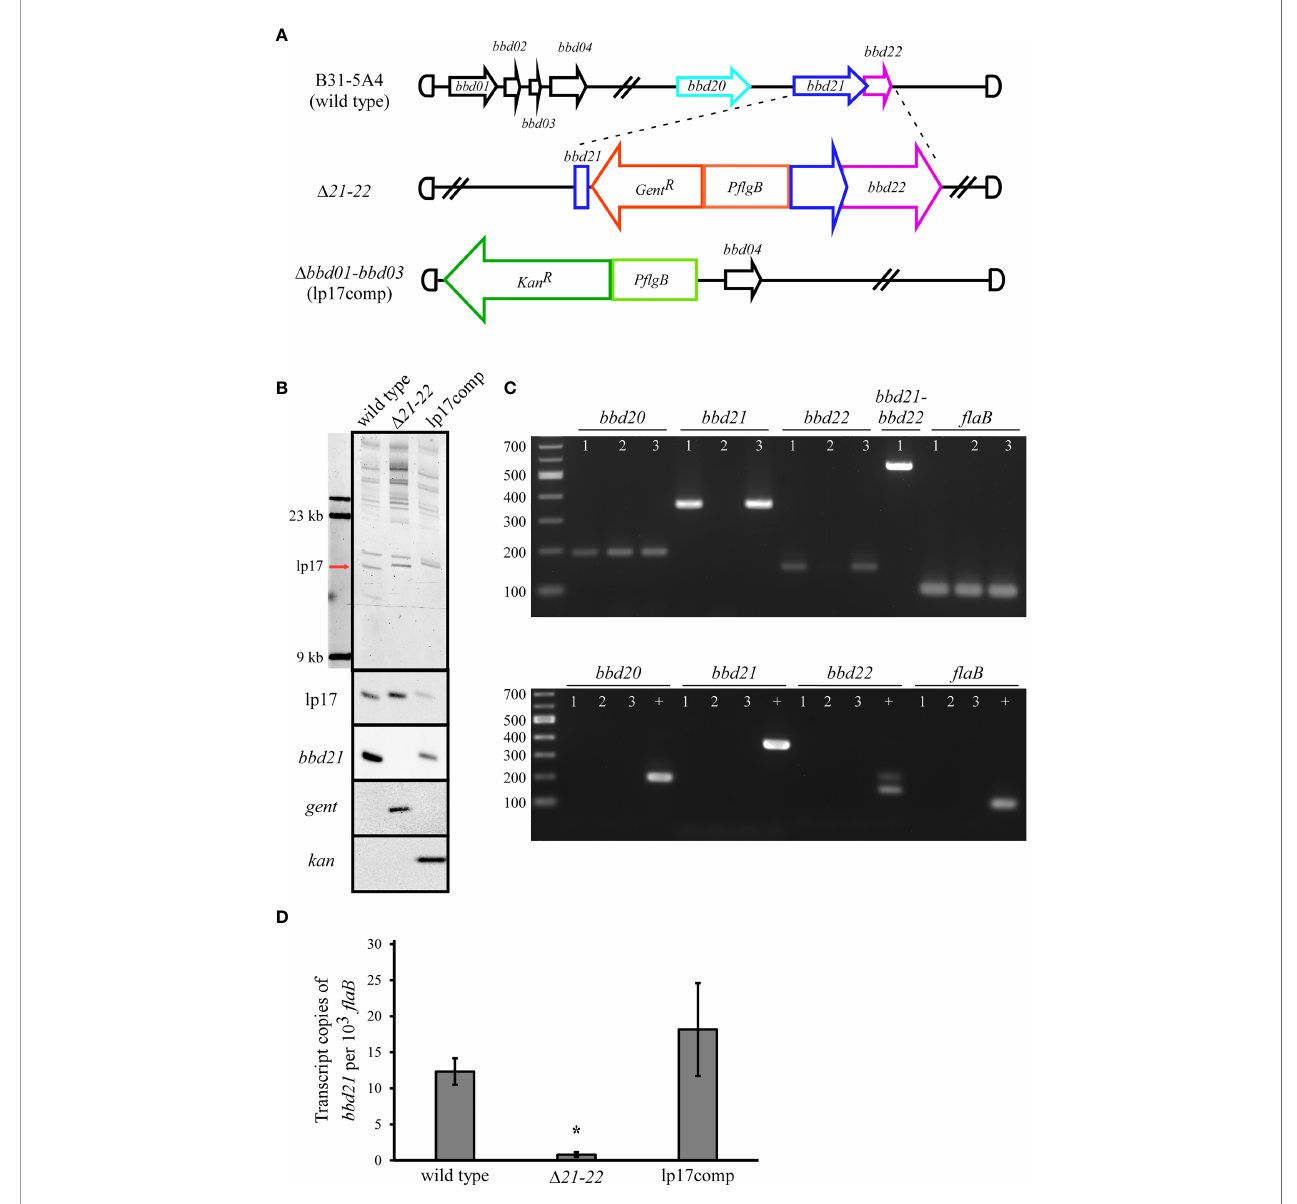
FIGURE 1 | Characterization of the bbd21-bbd22 mutant ( D 21-22 ) and complement (lp17comp). (A) Schematic of the B. burgdorferi strains generated in this study. The deletion mutant was generated in the 5A4 strain by allelic exchange resulting in a targeted internal deletion within bbd21 and replacement by a gentamicin resistance cassette driven by a fl gB promoter. The lp17comp clone was generated by whole plasmid transformation of a 5A4 mutant in which bbd01-bbd03 were replaced by a kanamycin resistance cassette driven by fl gB . (B) The fi eld inversion gel electrophoresis demonstrates 1 µg of genomic DNA loaded per lane, 23 kb and 9.4 kb size molecular markers, and the location of the lp17 plasmid (red arrow). The expected increased plasmid size of the deletion mutant and complement strains result from addition of antibiotic resistance markers. Southern blot analyses of wild-type, D 21-22 , and lp17comp genomic DNA probed for lp17, bbd21 , kanamycin , and gentamicin . (C) The upper gel depicts reverse-transcription PCR assessment of bbd21 deletion. Total RNA was isolated, converted to complementary DNA, and used to amplify regions within bbd21 , the fl anking genes bbd20 and bbd22 , an overlapping region of bbd21-bbd22 , and fl aB . 1 = wild type, 2 = D 21-22 , and 3 = lp17comp. A 194 bp region of bbd20 was ampli fi ed using P1399 and P1400, a 362 bp region within the bbd21 internal deletion was ampli fi ed using P1056 and P1057, a 157 bp region of bbd22 was ampli fi ed using P1401 and P934, a 565 bp region overlapping bbd21 and bbd22 was ampli fi ed using P1299 and P934, and a 105 bp region of fl aB was ampli fi ed using P411 and P412. The lower gel depicts RNA template (no transcriptase) negative controls and wild-type genomic DNA positive controls (+). (D) qRT-PCR analyses of bbd21 transcription from in vitro -cultivated wild-type, D 21-22 , and lp17comp strains. Transcript levels for bbd21 were normalized to 10 3 copies of fl aB using a TaqMan-assay. Values were expressed as an average of three experiments ± standard error mean. *p<0.05 (Student ’ s t